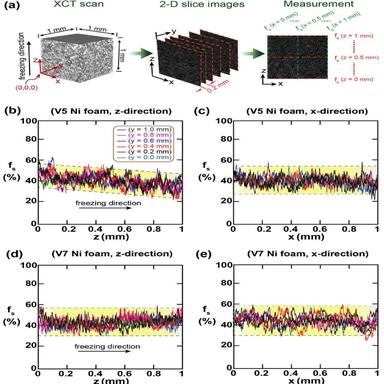
Solid area fraction analysis of freeze-cast Ni foams using XCT. (a) Schematic illustration of the procedure. Six slices of xz-plane images from the XCT scan, each spaced 0.2 mm apart along the y-direction were extracted. On each slice, the solid area fraction f s as a function parallel the freezing direction (z) and perpendicular to the freezing direction (x) were determined by averaging the pixel values for each row and column of pixels, respectively. (b–e) Solid area fraction of V5 (b, c) and V7 (d, e) Ni